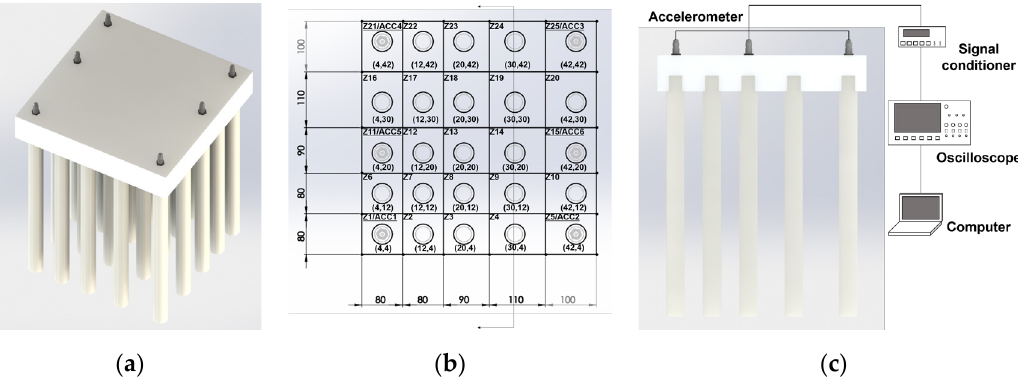
Figure 2. A schematic diagram of ( a ) a scaled PRF model, ( b ) the location of pile foundation and accelerometers, and ( c ) setup for data acquisition (not to scale).